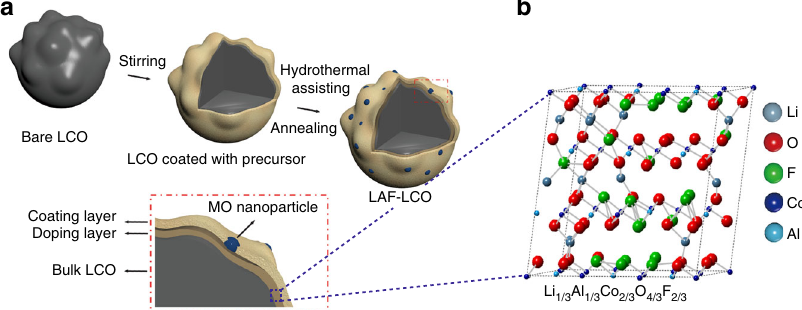
Fig. 1 The formation and synthetic process for constructing LAF-LCO. a Schematic illustration for the synthetic process to produce LAF-LCO. b The most probable supercell structure of Li-Al-Co-O-F solid solution using stoichiometric